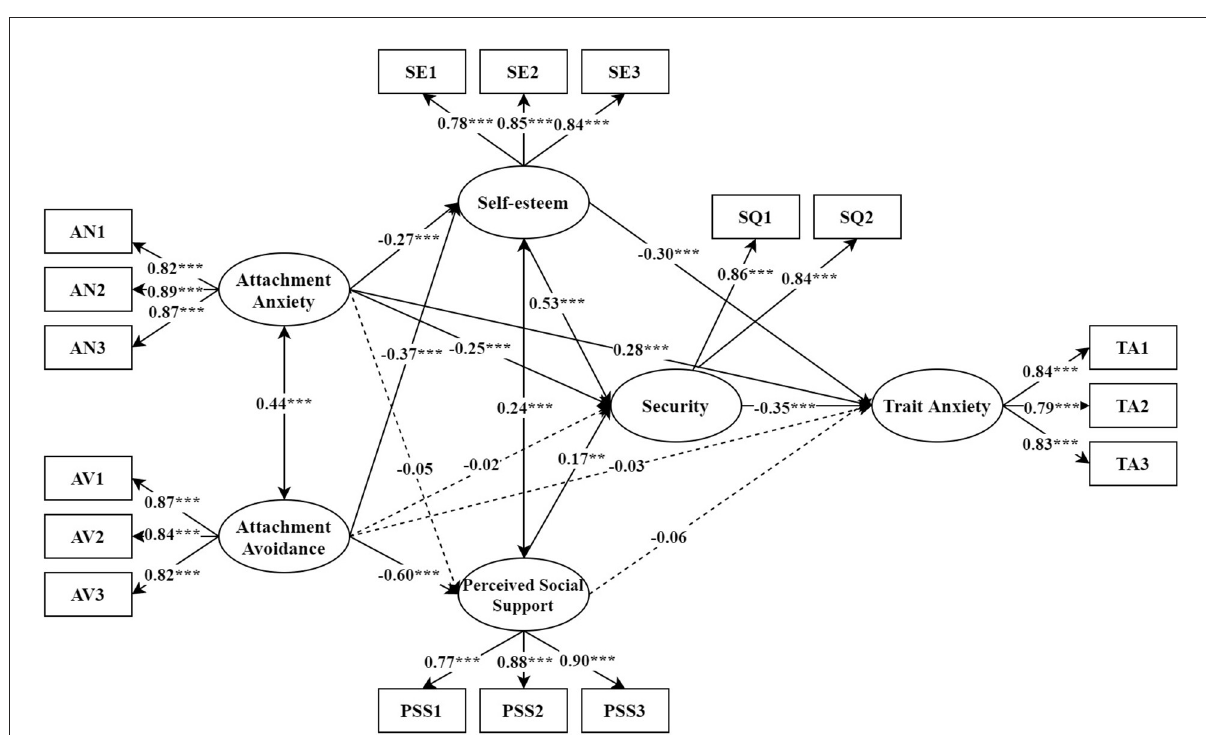
FIGURE2 Multiple mediation model. Dashed lines indicate nonsignificant paths. AN1–AN3 = three parcels of attachment anxiety; AV1–AV3 = three parcels of Attachment avoidance; SE1–SE3 = three parcels of self-esteem; PSS1 = family support; PSS2 = friend support; PSS3 = other support; SQ1–SQ2 = two parcels of security; TA1–TA3 = three parcels of trait anxiety. ** p < 0.01, *** p <